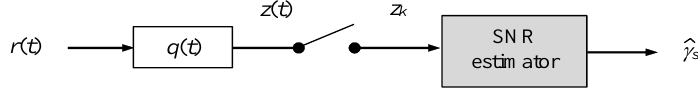
Figure 1. Signal model for SNR estimation.